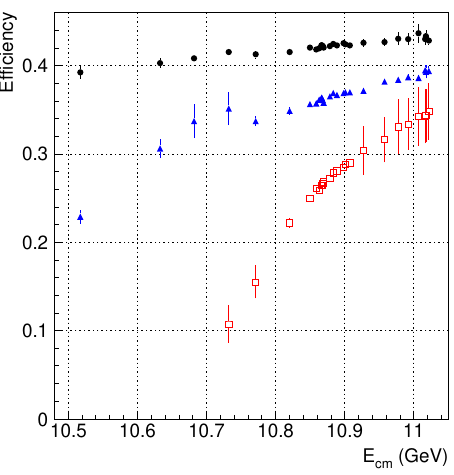
Figure 5 . Reconstruction e(cid:14)ciency as a function of the c.m. energy for the (cid:7)(1 S ) (cid:25) + (cid:25) (cid:0) (black (cid:12)lled dots), (cid:7)(2 S ) (cid:25) + (cid:25) (cid:0) (blue triangles), and (cid:7)(3 S ) (cid:25) + (cid:25) (cid:0) (red open dots) channels. The error bars show the systematic uncertainties associated with the DP